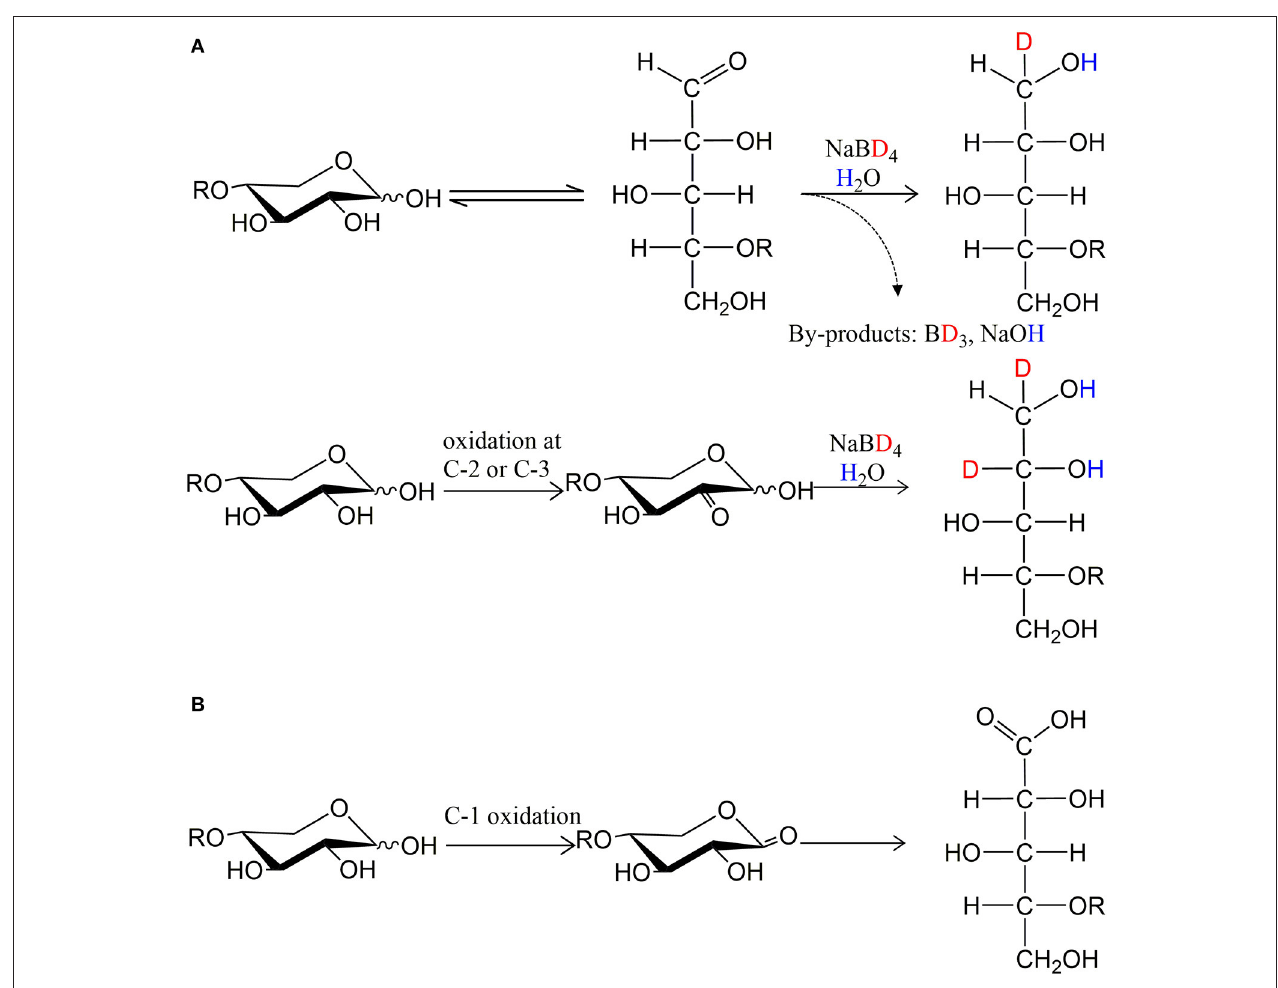
FIGURE 3 | The principle of isotopic labeling with NaBD 4 reduction. (A) One oxidation at secondary hydroxyls is equivalent to one Dalton difference in mass and (B) oxidation at C-1 hydroxyl is resistant to NaBD 4 reduction.